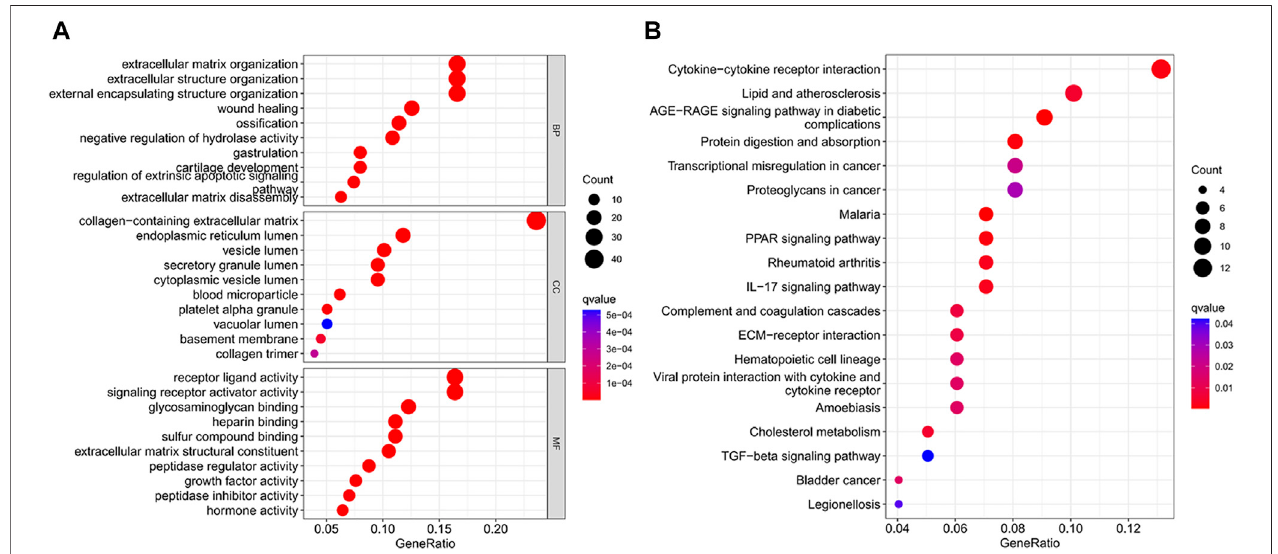
FIGURE 7 | Differential gene enrichment analysis. (A) GO enrichment analysis bubble map. (B) Bubble plot of KEGG enrichment analysis.